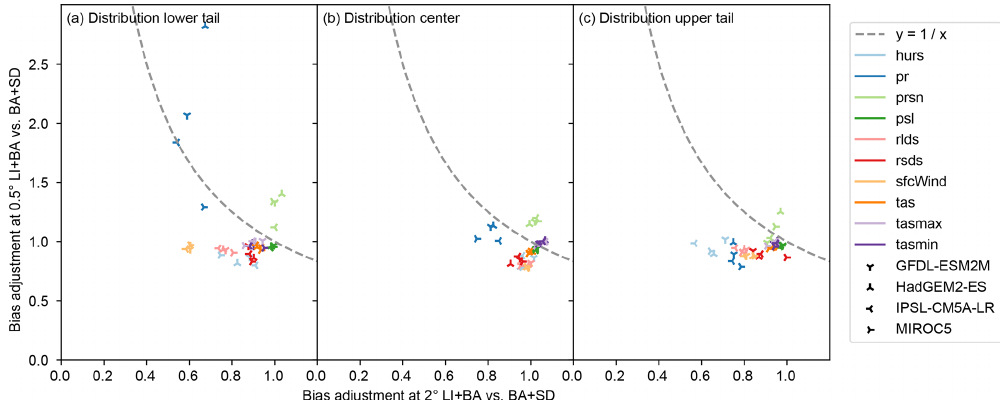
Figure 9. Same as Fig. 8 but with goodness of bias adjustment at 0 . 5 ◦ spatial resolution on the y axis.